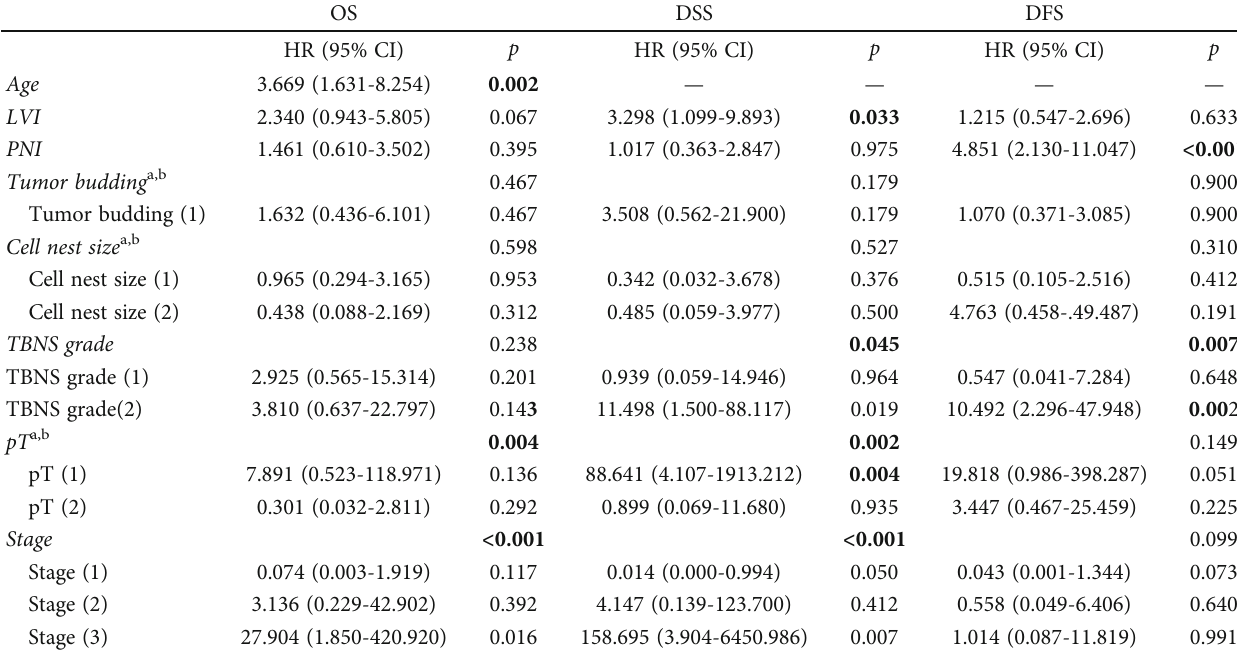
Table 2: Multivariate analysis for overall survival, disease-speci fi c survival, and disease-free survival in ureter urothelial carcinoma. OS DSS